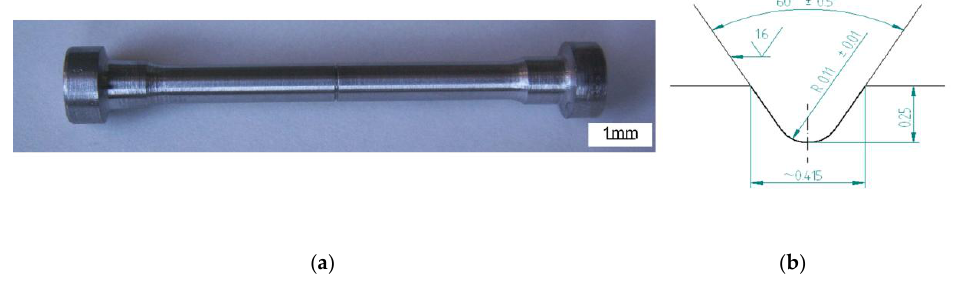
Figure 2. Image of the specimen ( a ) The notched tensile specimen before test and ( b ) the notch profile (in mm). (in mm).